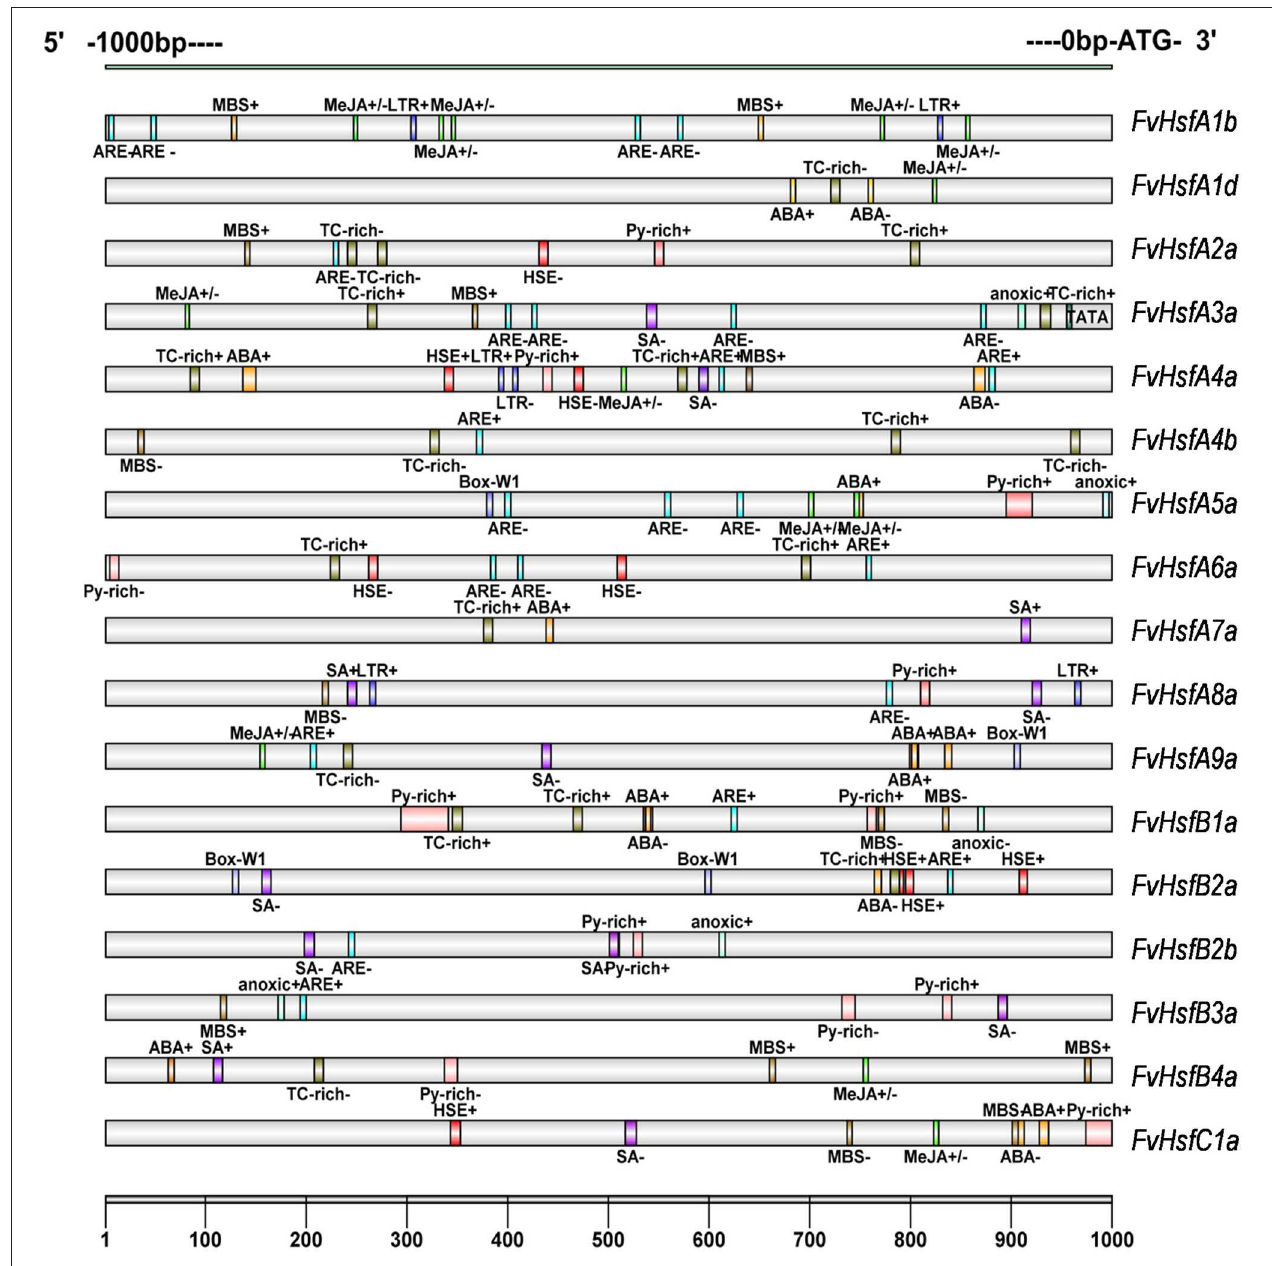
FIGURE 3 | Cis -elements are present in the 1kb region upstream of the strawberry Hsf translation start site. The analysis was performed using the PlantCARE database. The different-colored boxes mark the relative positions of the different elements.